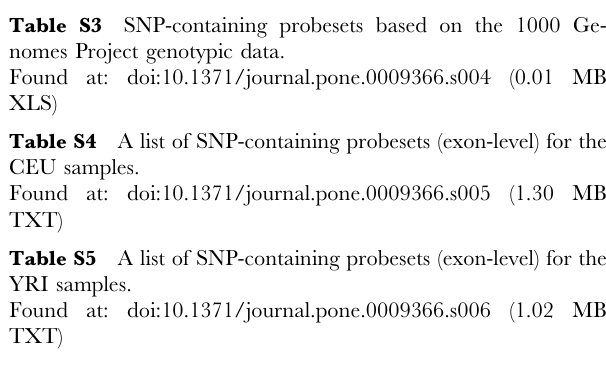
Table S6 Chromosomal distribution of probesets with common SNPs.